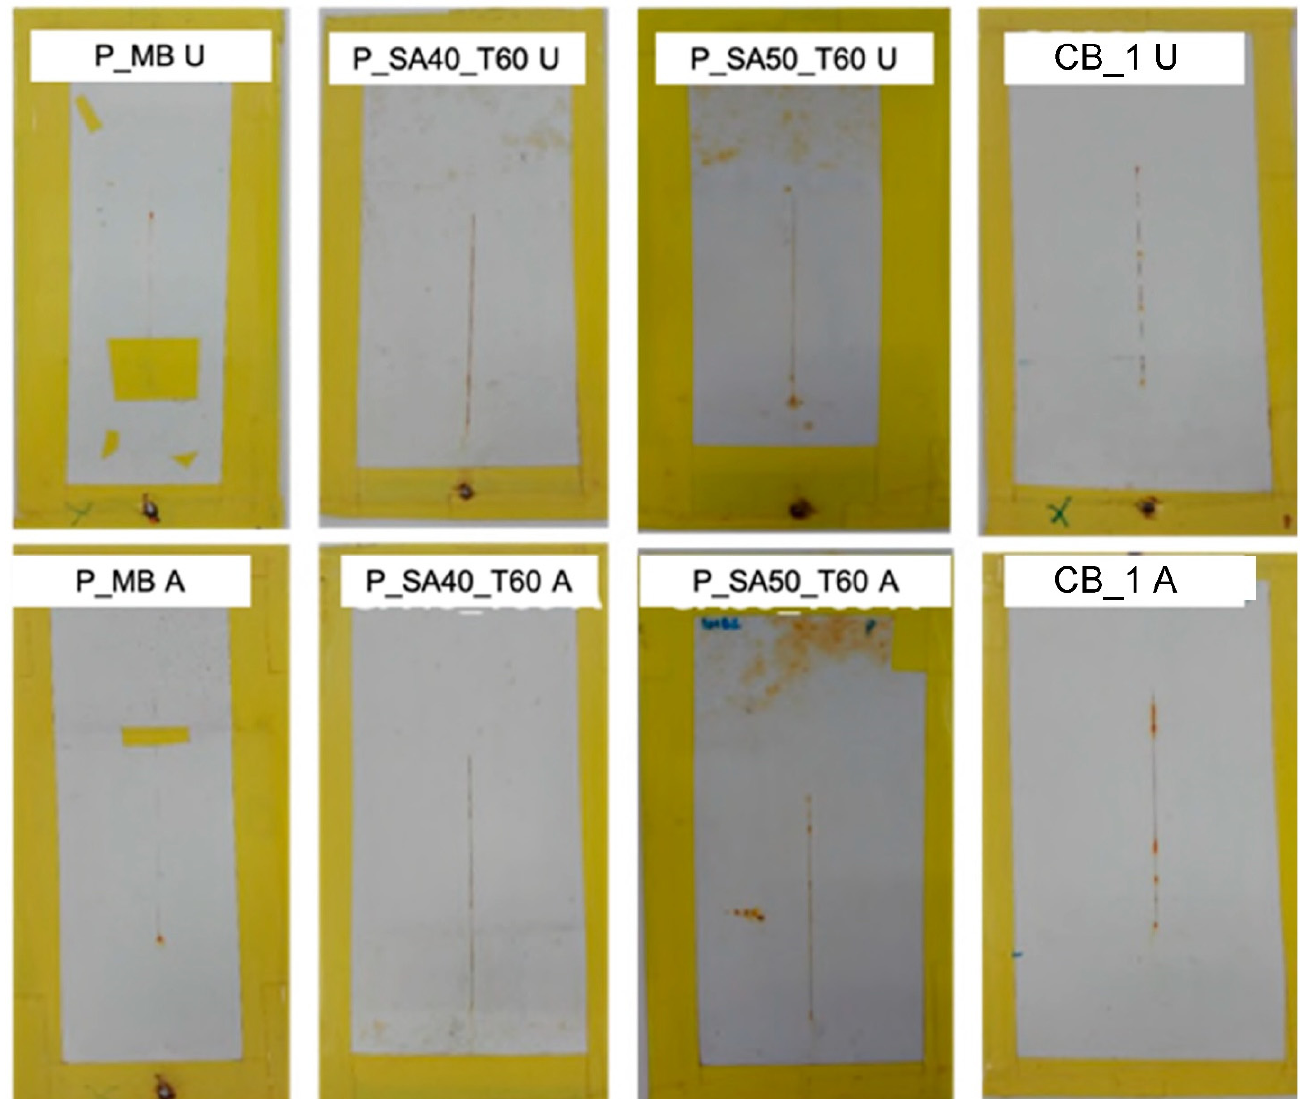
Figure 7. Results of cyclic high humidity-weathering test for scribed specimens coated with the formulated paints on steel cleaned with the different cleaning procedure (A and U) after 2000 h of exposure. Note: P_SA40 and P_SA50 coated specimen and dried at ambient temperature have not been tested due to the degradation of those after the first cycle of exposition at high humidity.